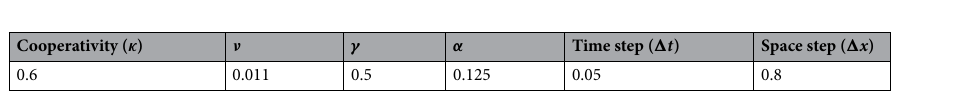
Figure 3. Numerical observations of localised labyrinths. The model-independent structure is observed in ( a ) a non-variational Swift–Hohenberg model, ( b ) integrodifferential non-local model, and ( c ) reaction–diffusion model. In the three cases the labyrinth is supported by a uniform vegetated state. The parameters used in each model are listed in the "Methods" section. From numerical simulations, the figure was created using Inkscape 1.0 (https:// inksc ape. org/ relea se/ inksc ape-1. 0/).